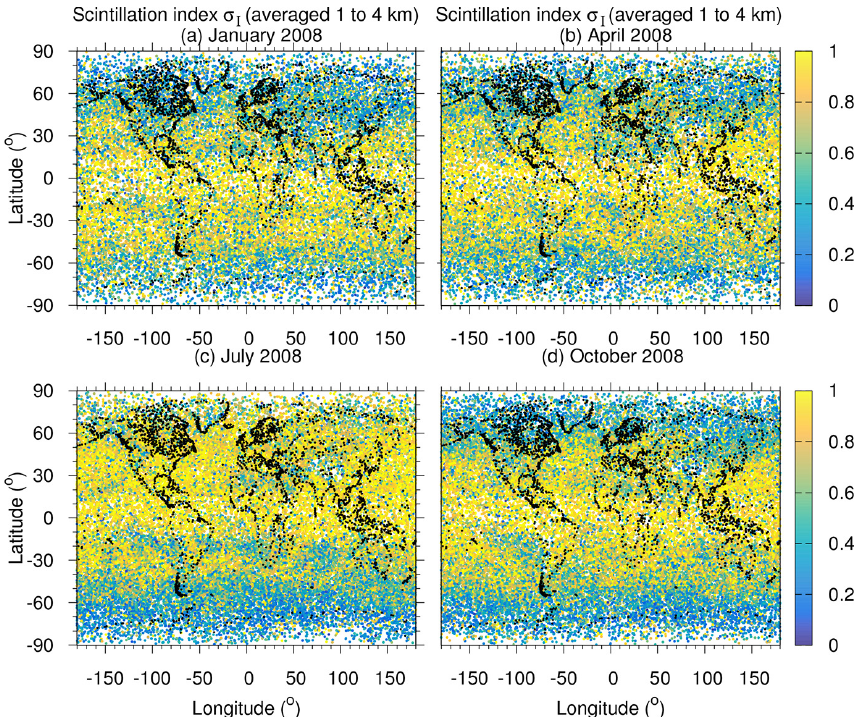
Figure 1. Global map of altitudinal average (1–4km altitudes) scintillation index derived from the COSMIC RO data for January, April, July, and October